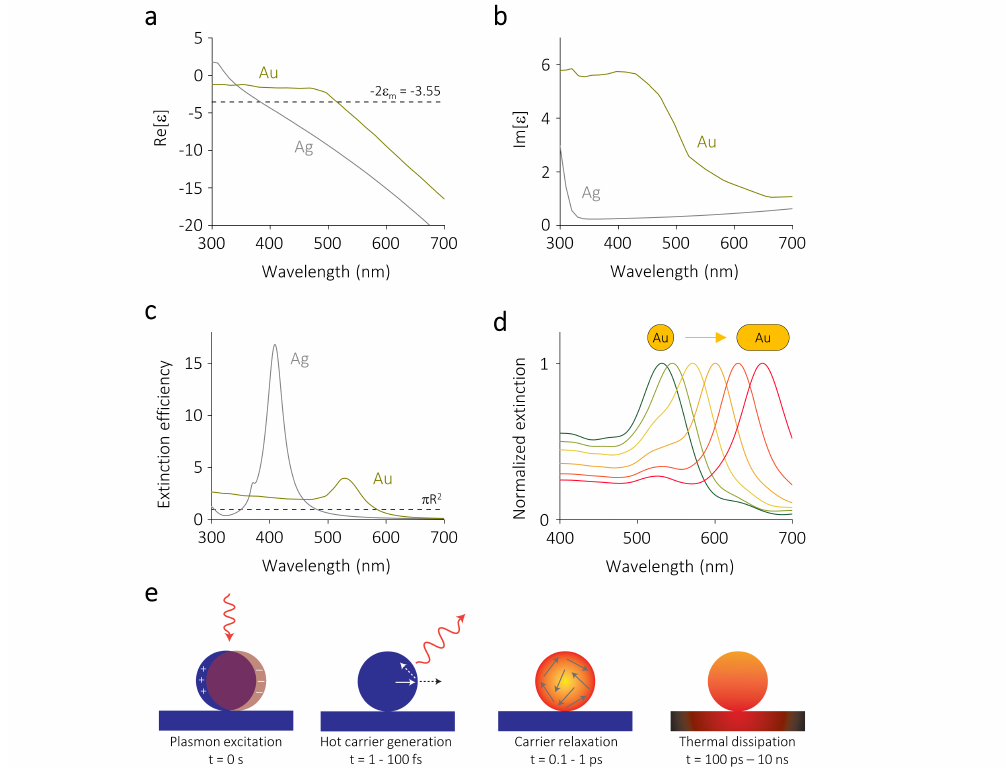
Figure 1. Optical properties of metallic nanoparticles. ( a ) Real and ( b ) imaginary part of the wavelength-dependent permittivities of gold (Au) and silver (Ag). The dotted line in panel ( a ) denotes the resonance condition (cid:101) = − 2 (cid:101) m when the surrounding medium is water. The permittivities are taken from the literature [55,56]. ( c ) Extinction cross sections of spherical nanoparticles of gold and silver with radii R = 25 nm. The cross sections are calculated using Mie theory and are normalized to the geometrical cross section π R 2 , which is denoted by the dashed horizontal line. ( d ) Normalized extinction cross section of a gold sphere of R = 25 nm, that is elongated in steps of 10 nm to a gold rod with a total length of 100 nm. The cross sections are calculated using a finite-difference time-domain method. ( e ) Localized surface plasmon resonances (LSPRs) can decay radiatively (scattering) into photons or non-radiatively (absorption) into non-equilibrium charge carriers. These carriers relax via electron-electron scattering, followed by electron-phonon scattering, which heats up the nanoparticle and eventually also the surrounding medium. Panel ( e ) reproduced with permission of [2].